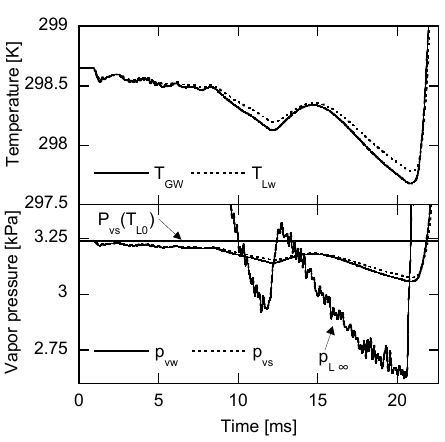
Bubble motion by large pressure reduction ( Δ p = 99 kPa).